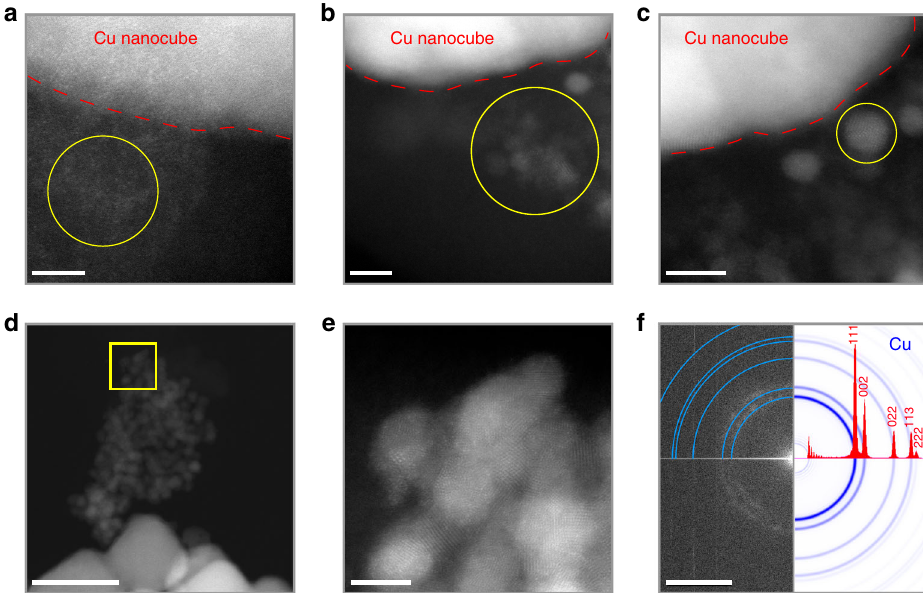
Fig. 2 Characterizations of the Cu nanoclusters formed during electrolysis. a – e High-resolution HAADF-STEM images of a , b Cu nanoclusters (<3 nm) and c – e Cu nanoparticles (~5 nm) formed from the 41 nm CuNCs during electrolysis for 4.5 h under CO 2 RR conditions. Circles in a , b , and c enclose regions containing nanoclusters and nanoparticles, respectively. e is a high-magni fi cation view of the region boxed in d . f FFT of the HR-STEM image shown in e . Simulated electron diffraction pattern (blue rings: ring sampling diffraction planes; red spectrum: intensity pro fi le) of Cu are included for reference. Scale bars: a 3 nm, b , c , e 5 nm, d 50 nm, and f 5 nm −